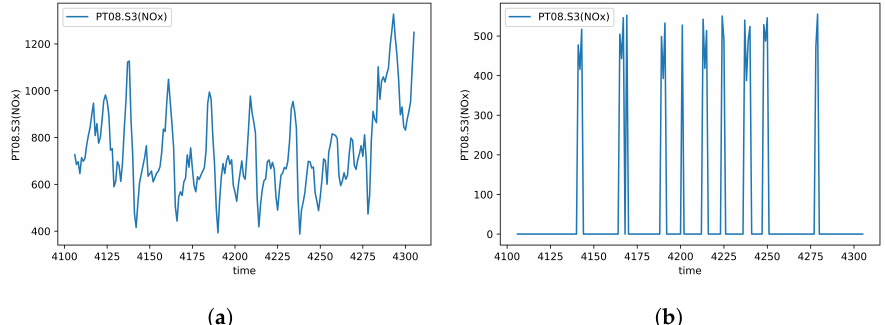
Figure 3. NOx over 200 samples in Italy Air Quality. ( a ) Actual data; ( b ) Generated missing